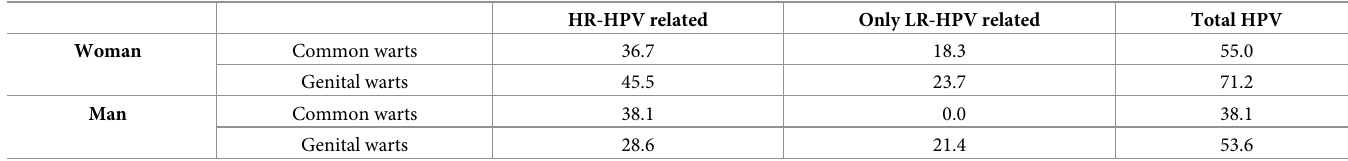
Table 4. HPV prevalence associated with common warts and genital warts.